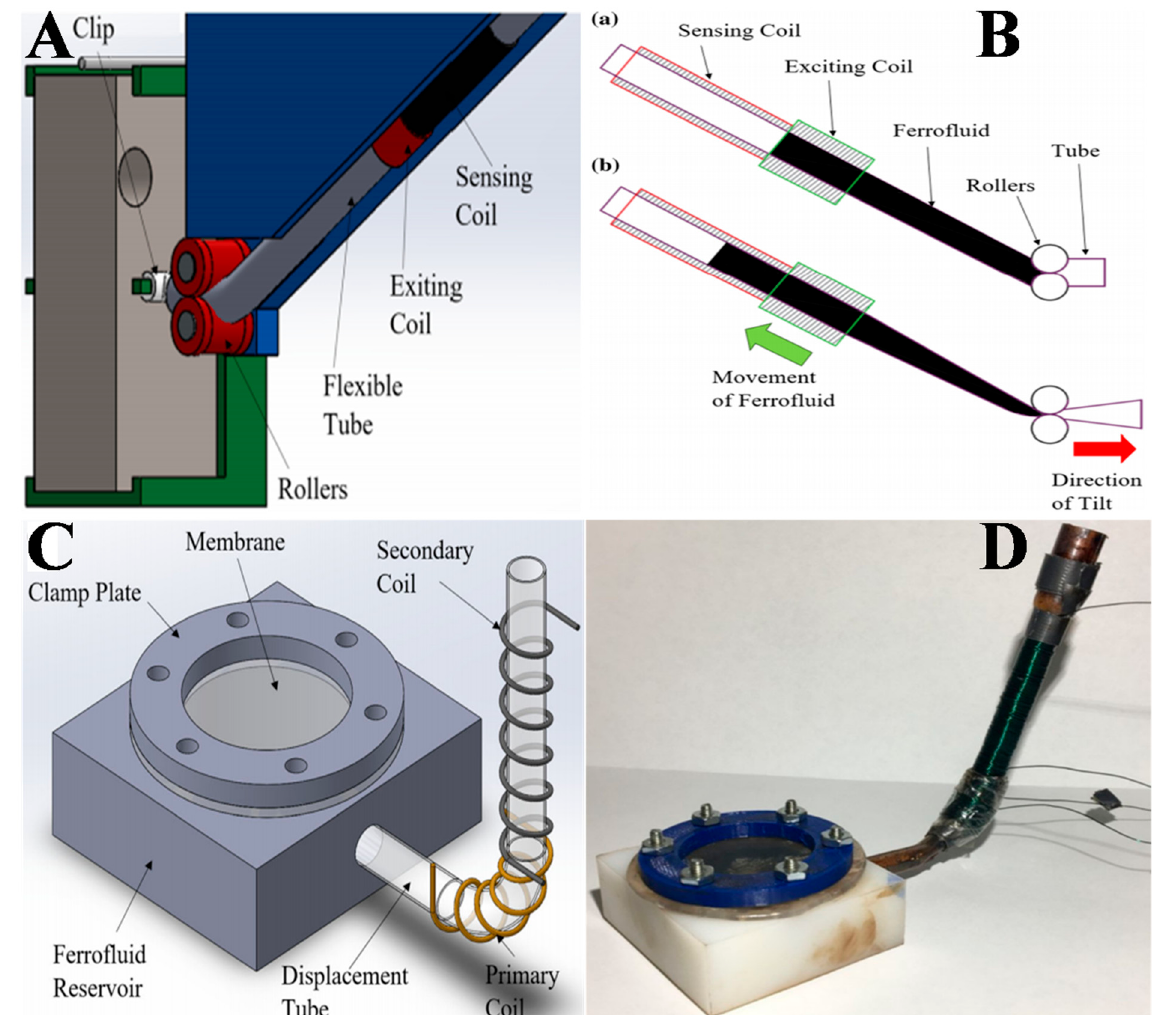
Figure 9. ( A ) Model of the proposed tilt sensor showing the connections of mass, coils, tubes, and rollers; ( B ) working principle of the proposed tilt sensor illustrating its roller system when the sensor is ( a ) “at rest” and ( b ) in a “tilting” state. Reprinted with permission from Ref. [93]. Copyright 2020, Springer Nature ( C ) Model of the FN − based force sensor; ( D ) fabrication of the proposed FN − based force sensor. Reprinted with permission from Ref. [94]. Copyright 2020, Springer Nature.